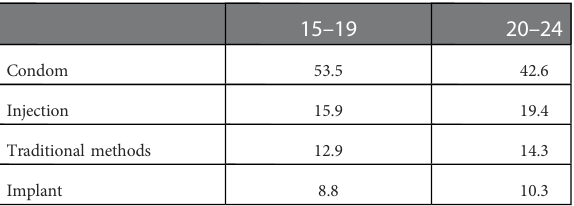
TABLE 2 Leading methods used by unmarried sexually active women across all LMICs with available data.